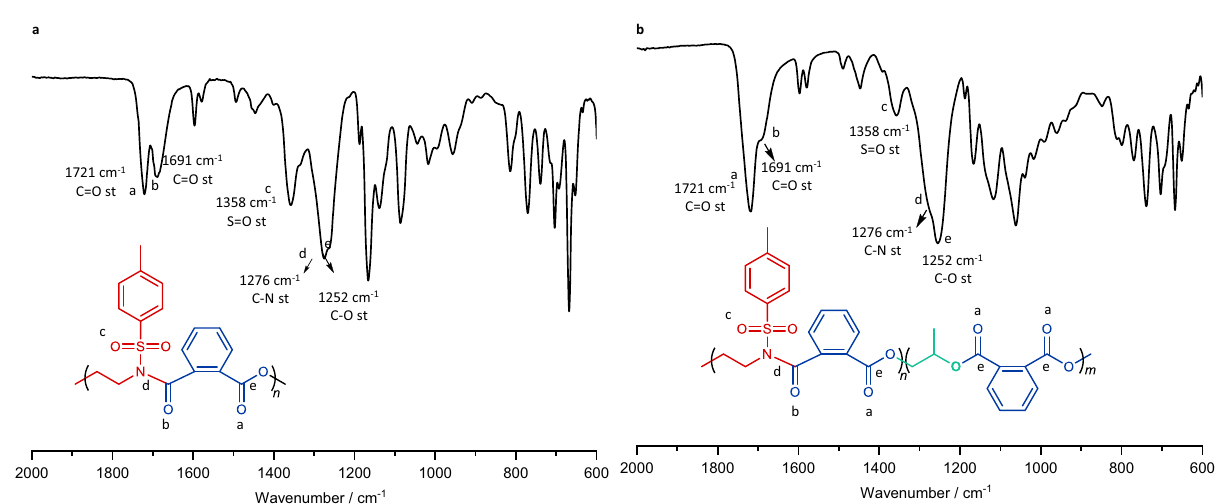
Fig. 3 Fourier-transform infrared spectroscopy (FTIR) characterization. a FTIR spectra of poly(TAz- alt -PA). b FTIR spectra of poly(TAz- alt -PA)- b - poly(PA- alt -PO).